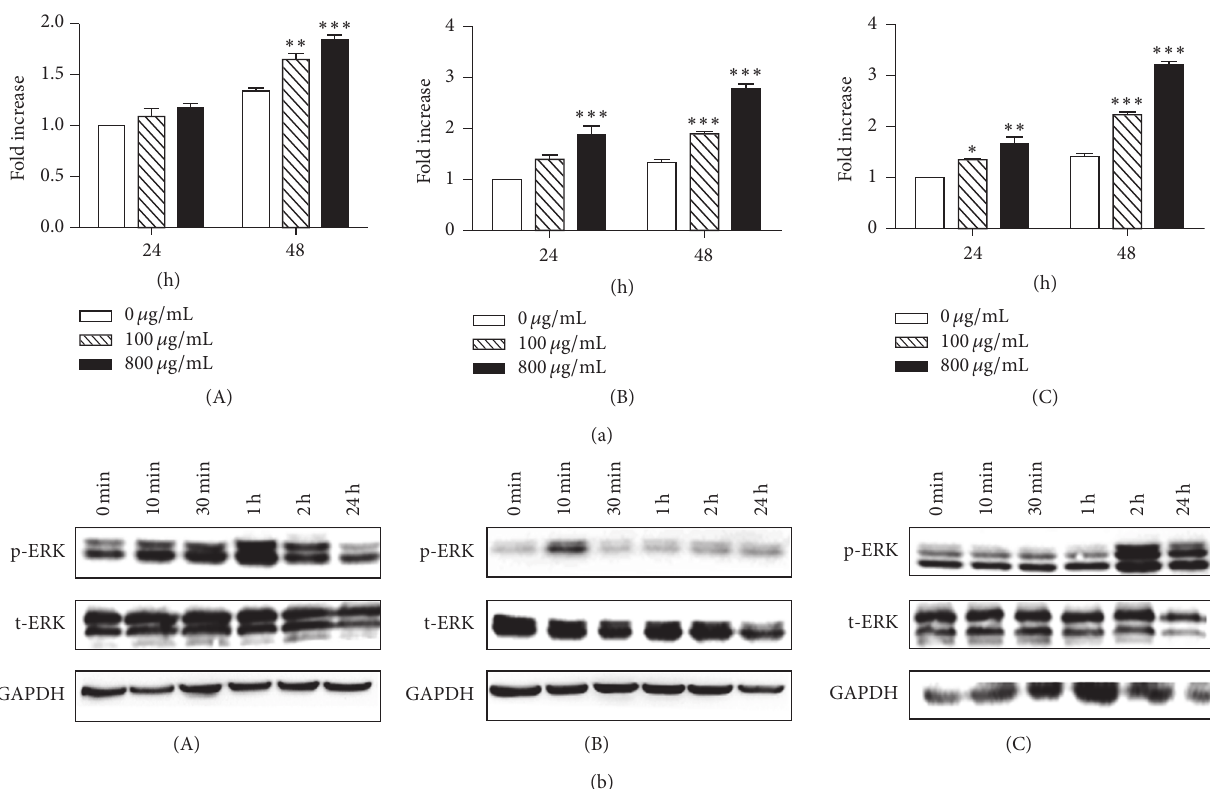
Figure 2: HucMSCs-exosomes promote cell proliferation in vitro . (a) HucMSCs-exosomes promote cell proliferation in a dose- and time- dependent manner. Results were shown as mean ± SD ( 𝑛 = 5 ). ∗ 𝑝 < 0.05 , ∗∗ 𝑝 < 0.01 , and ∗∗∗ 𝑝 < 0.001 compared to control group. (b) Western blotting analysis of phosphorylated ERK1/2 in cells treated with 800 𝜇 g/mL hucMSCs-exosomes as indicated. (A) H9C2(2-1); (B) HL-7702; and (C)